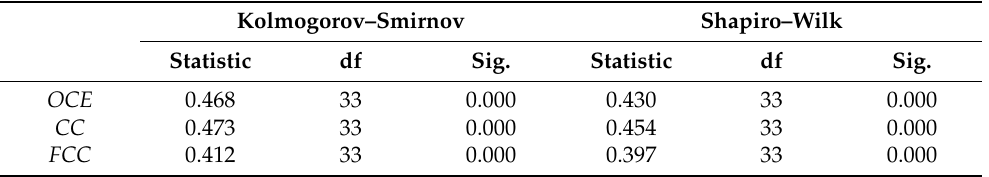
Table 4. Normality test of transformed